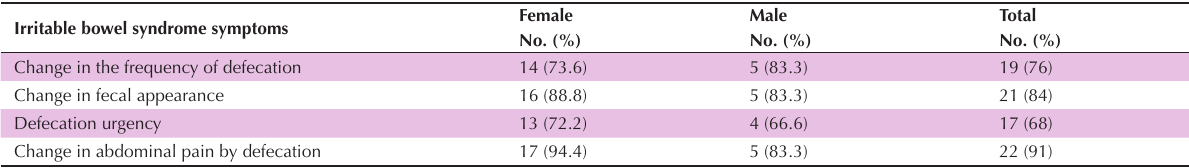
Table 1. The symptoms of irritable bowel syndrome in the medical students Irritable bowel syndrome symptoms